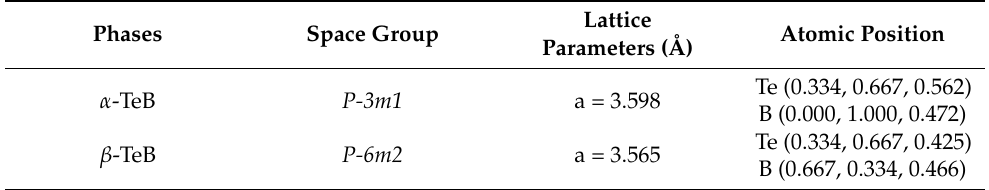
Table 1. Optimized lattice parameters and atomic positions for α -TeB and β